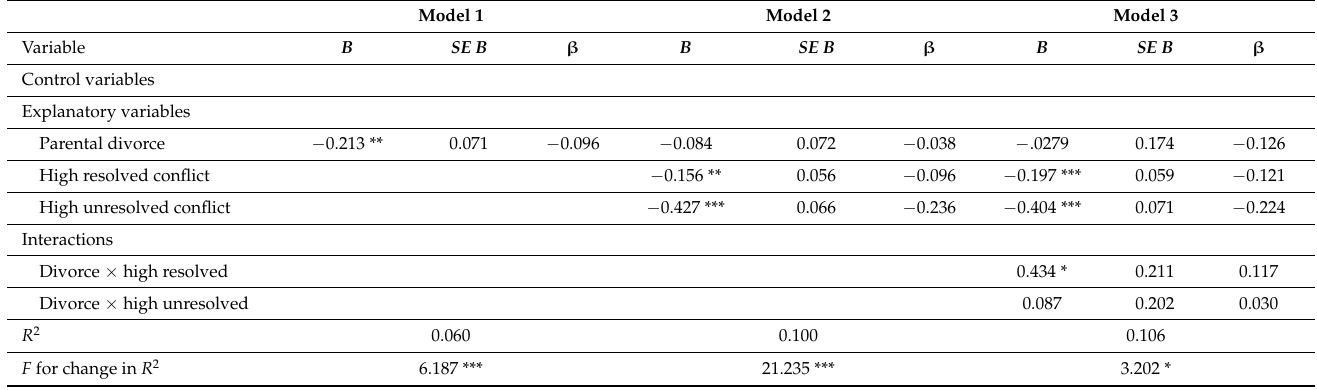
Table 4. Summary of the hierarchical multiple regressions for the variables predicting communication in mother-child relationships.